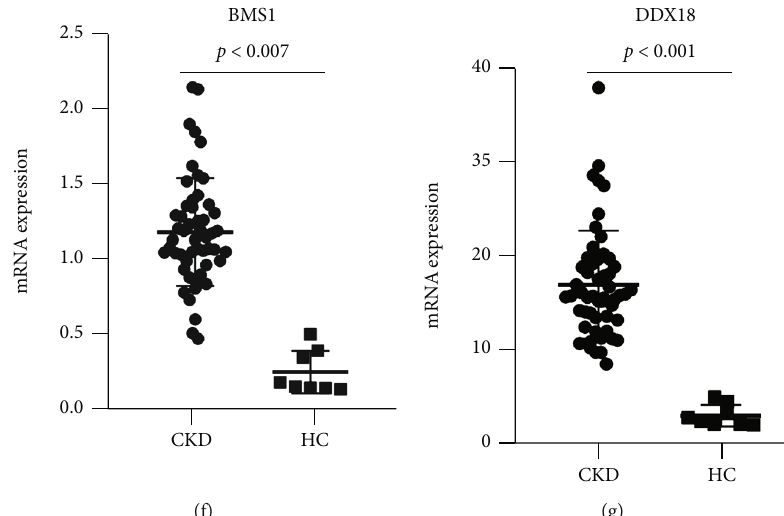
Figure 5: The hub genes screened out were validated in the validation dataset including GSE142153 and GSE70528. (a) A total of 6 molecules were considered to be highly associated with CKD, including CEBPZ, IFI16, LYAR, BRIX1, BMS1, and DDX18. Details of these hub genes include degree, MCODE_score in Cytoscape, fold changes, and P value in the interaction network in CKD patients compared to healthy controls. (b) mRNA expression of CEBPZ. (c) mRNA expression of IFI16. (d) mRNA expression of LYAR. (e) mRNA expression of BRIX1. (f) mRNA expression of BMS1. (g) mRNA expression of DDX18. CKD: patients with chronic kidney disease; HC: healthy human